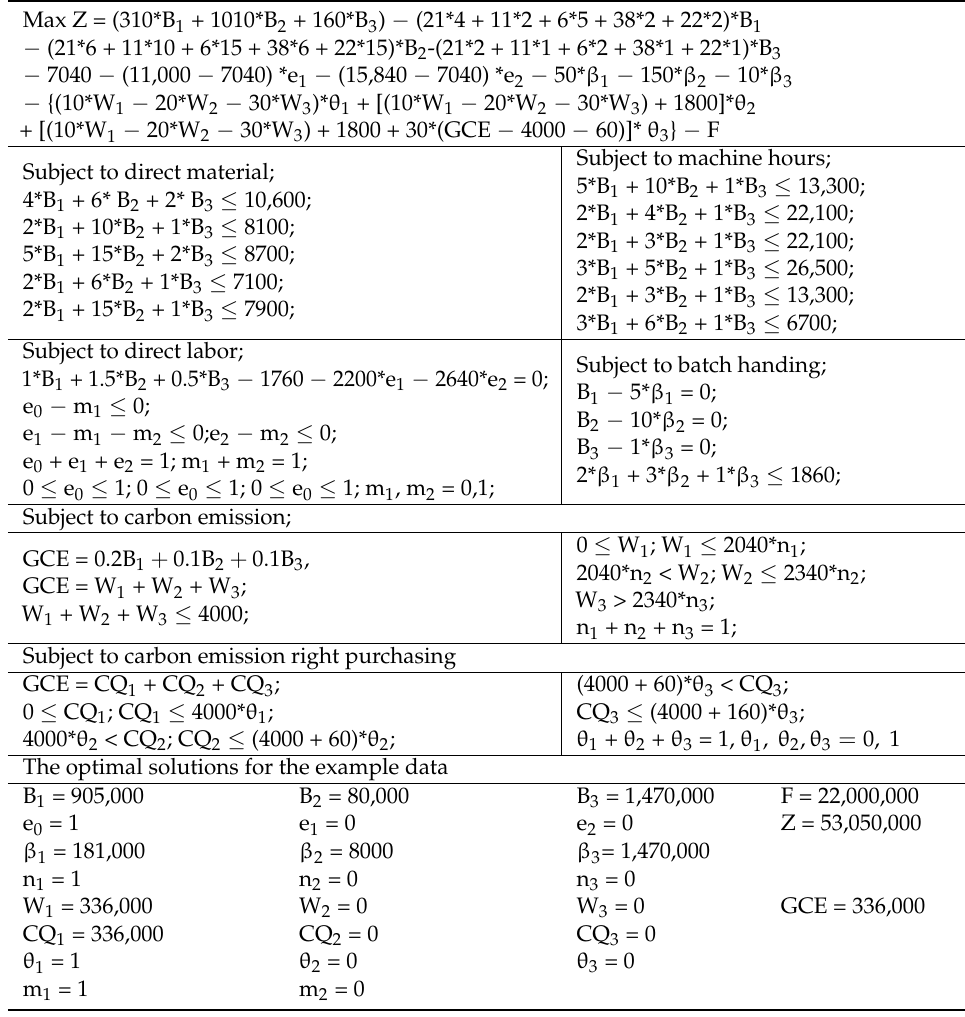
Table 4. The model and its optimal solutions with the illustrative data for Model